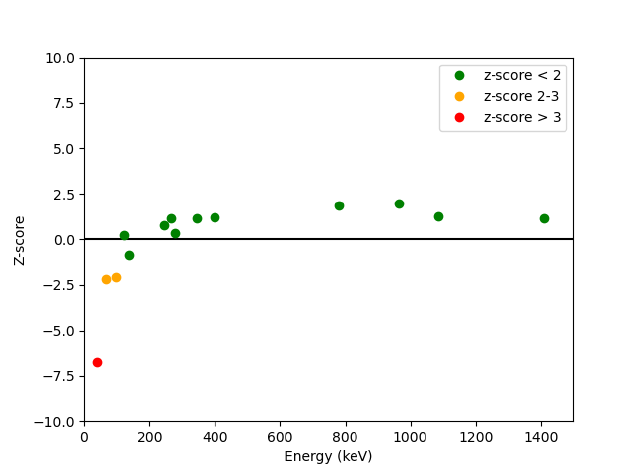
Figure 2, The peak area z-score for an analysis where the shape of the efficiency calibration is different from the shape of the sample efficiency Another common cause for inconsistency is missing interferences in the nuclide library. Missing interferences